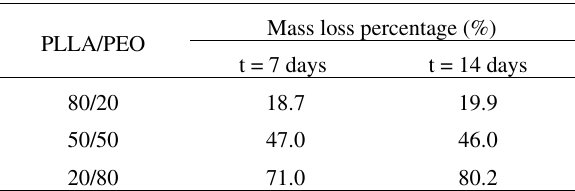
Table 1. Mass loss percentage obtained from the in vitro degradation tests for PLLA/PEO blends of different compositions as a function of the period of immersion in the